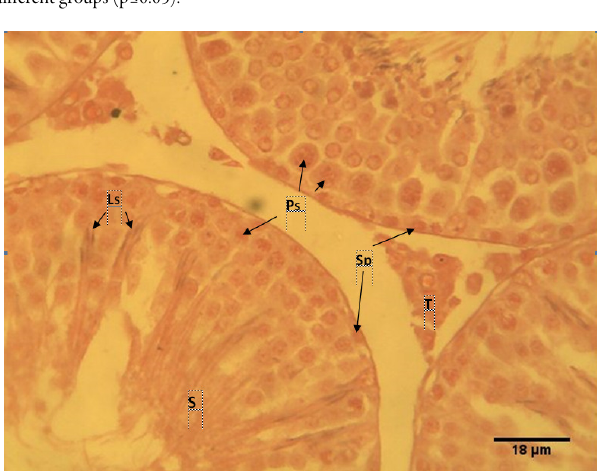
Fig. 1. Histological appearance of testis of rat given 0.25